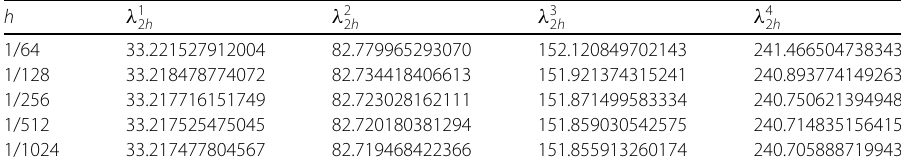
Table 3 a = 0, the four eigenvalues with l = 2 and h h